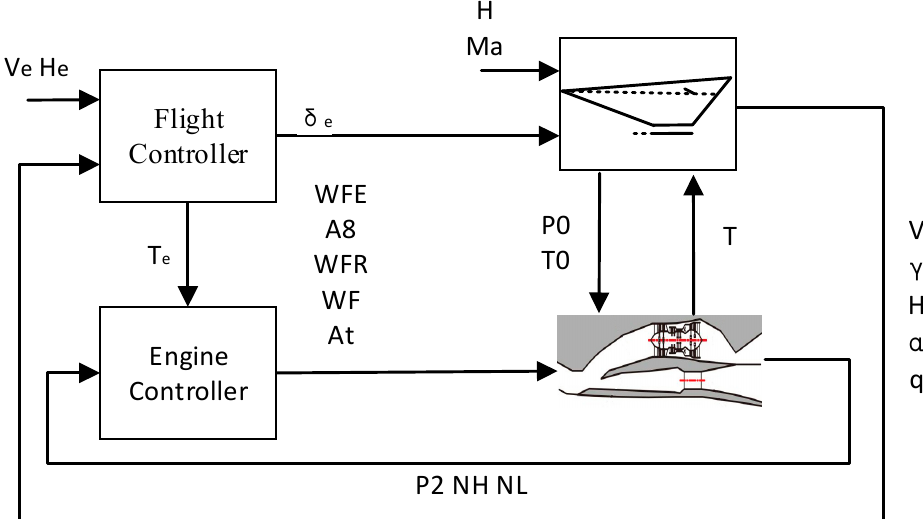
Figure 4. Structure of flight/propulsion integrated control system.